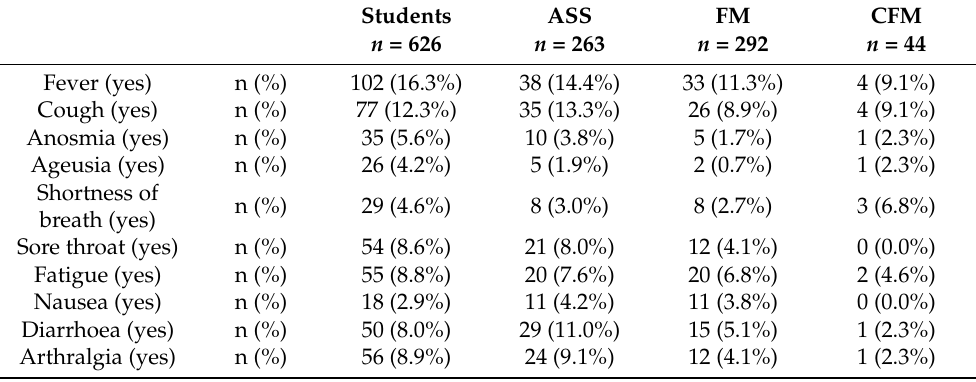
Table 2. COVID-19-related symptoms during 2020 in participants with at least one previous RT-PCR.